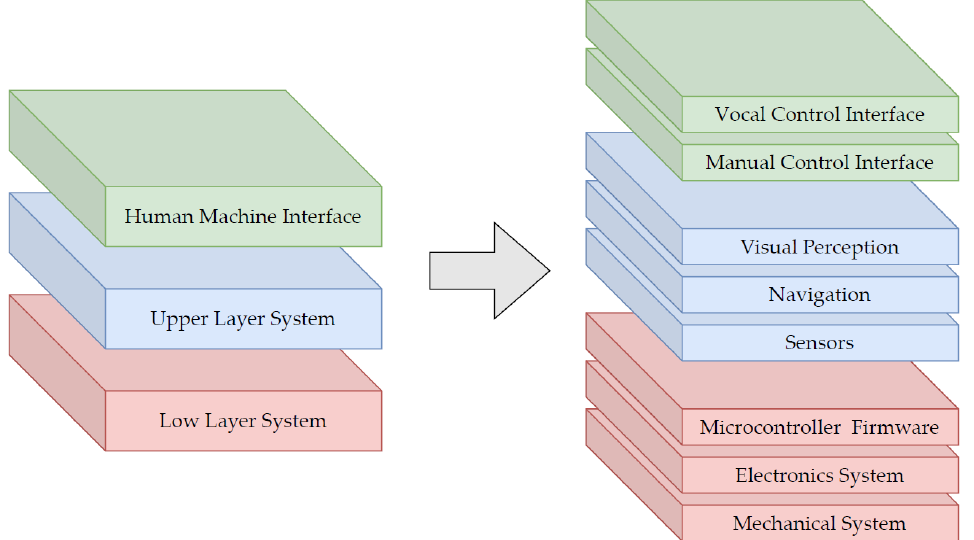
Figure 3. Schematic representation of the modular platform architecture. The three main layers of the architecture ( left ) are decomposed in their respective principal components ( right